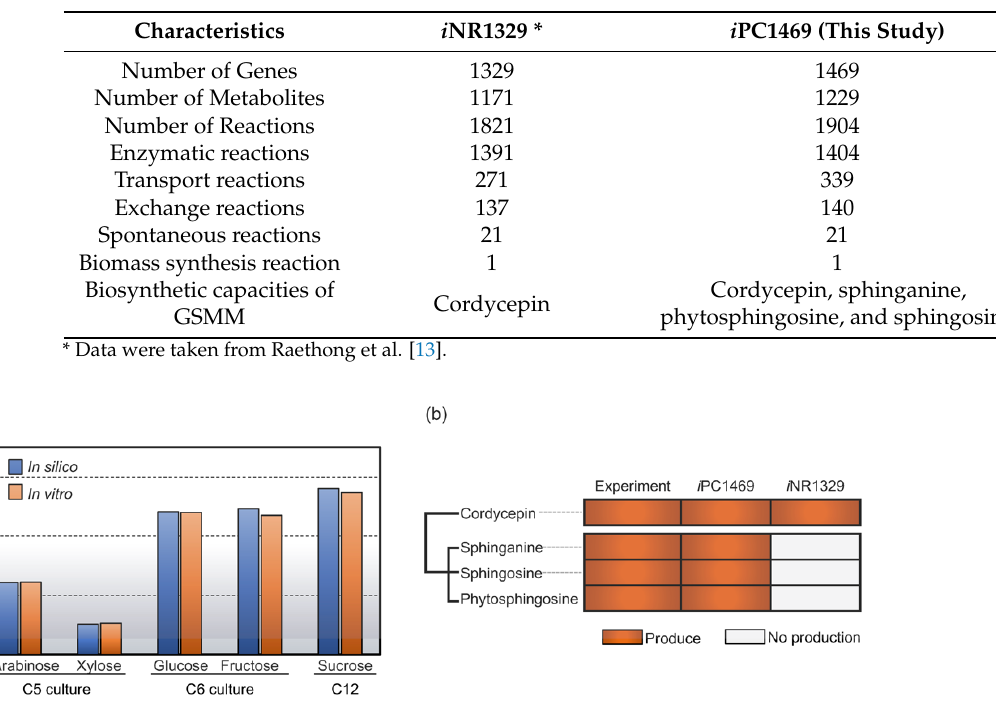
Figure 4. Validation of the enhanced GSMM, i PC1469. ( a ) Model validation by comparison of growth rate (day − 1 ) between in silico and in vitro data across different carbon sources. ( b ) The predictions of sphingolipid derivatives. Experimental data are shown in the first column, while the modeling results are shown in the rest columns.